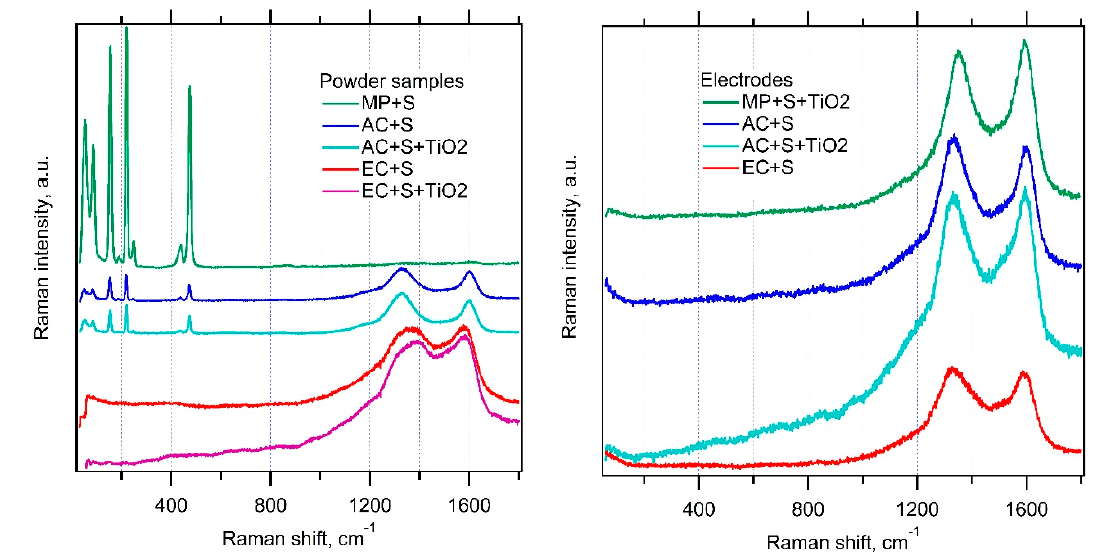
Figure 5. Raman spectra of the investigated materials in the form of starting powders ( left chart ) and complete electrodes in thin films at Al support ( right chart ). The spectra are offset for clarity, but the scale of intensity is the same in each chart.